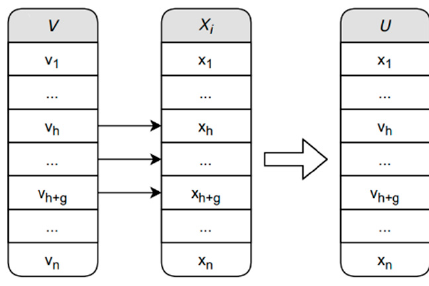
Figure 1. The final stage of the crossing-over procedure—calculation of the child vector 𝑈(cid:3365).